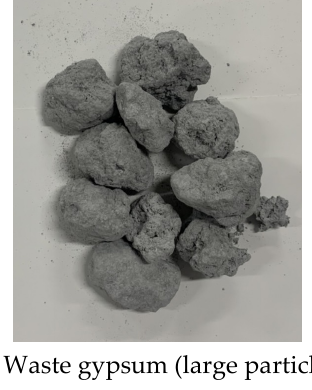
Figure 1. Appearance of waste gypsum.